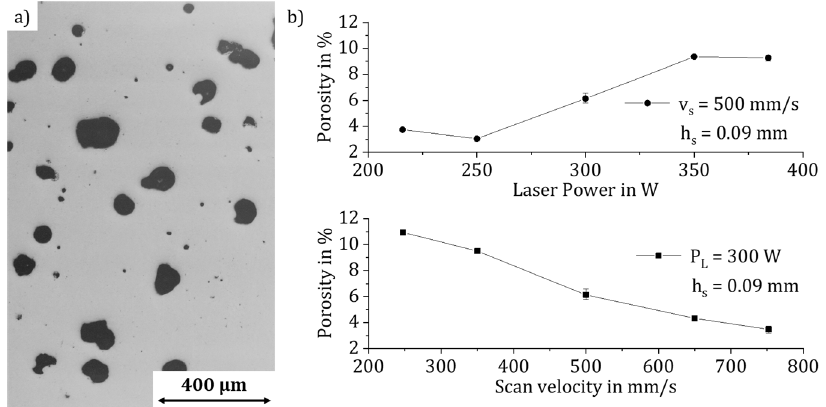
Figure 1. Influence of the main parameters P L and v s on the formation of process pores in the material AlSi10Mg: ( a ) microsection, ( b ) influence of the process parameters.